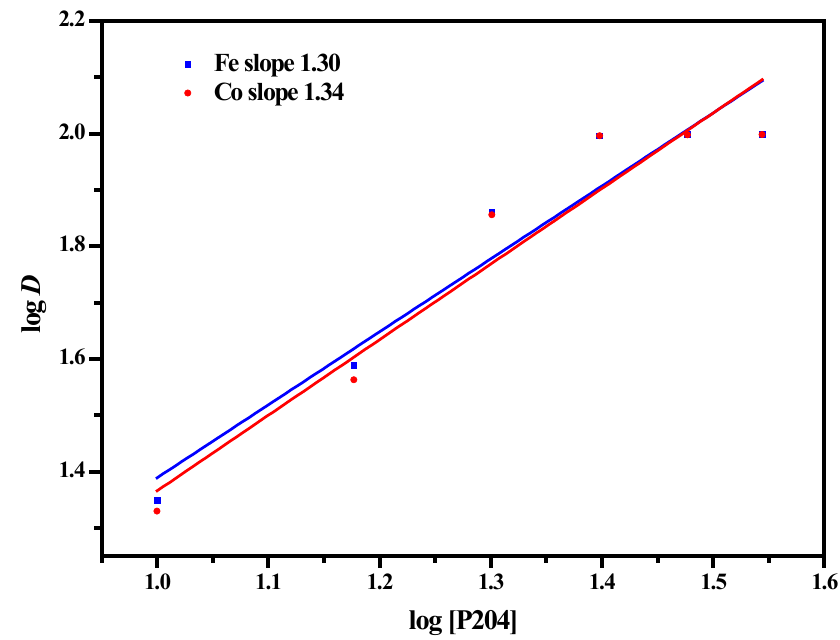
Figure 12. log D— log[P204] diagram of Fe and Mn.